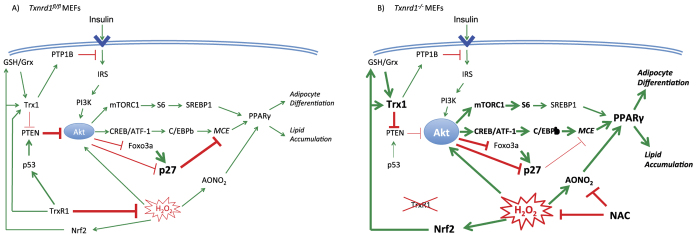
Signaling mechanisms triggering adipogenesis in MEFs lacking Txnrd1.These schemes graphically summarize our findings as reported herein regarding signaling pathways in (A) Txnrd1fl/fl functionally wildtype MEFs compared to (B) Txnrd1−/− knockout cells that contribute to increased adipogenesis in the latter. Stimulatory signaling pathways are indicated with green arrows while inhibitory mechanisms are shown with red block arrows. Note that many of these pathways may be indirect, rather than direct as simplified in these schemes. Thicker arrows and bold font suggest increased activities. Processes (rather than proteins or molecules) are indicated in italics, with MCE being “mitotic clonal expansion”. Note the increased Akt activity in Txnrd1−/− MEFs that together with PPARγ activation and increased oxidative stress (indicated by H2O2 and AONO2) triggers increased adipogenesis, which may be counteracted by NAC treatment. The mechanisms indicated in these schemes are further discussed in the text.